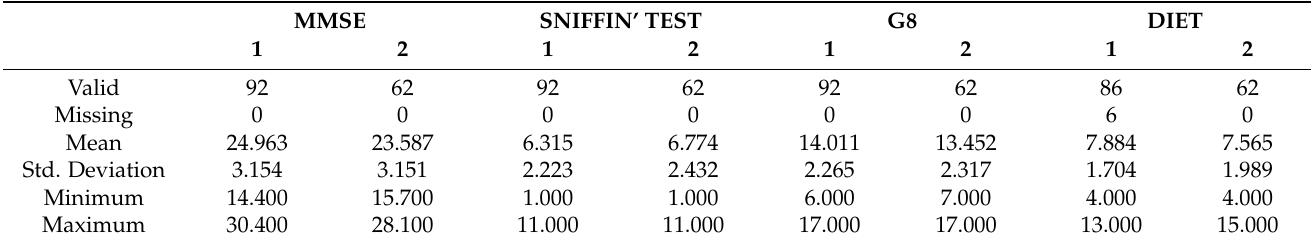
Table 3. Descriptive statistics for men (Group 1) and women (Group 2) for each test. Differences in Table 4. Descriptive statistics for MMSE, Sniffin’ Test, G8 and Diet scores for Group 1 (i.e., scores on MMSE are significant.